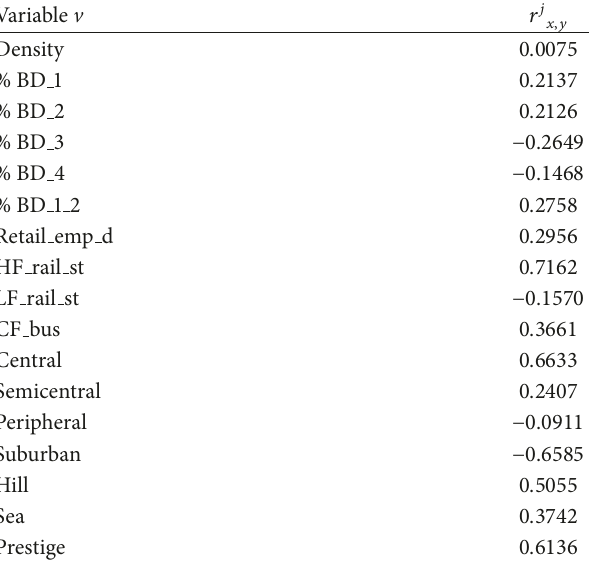
Table 4: Correlation coefficients.